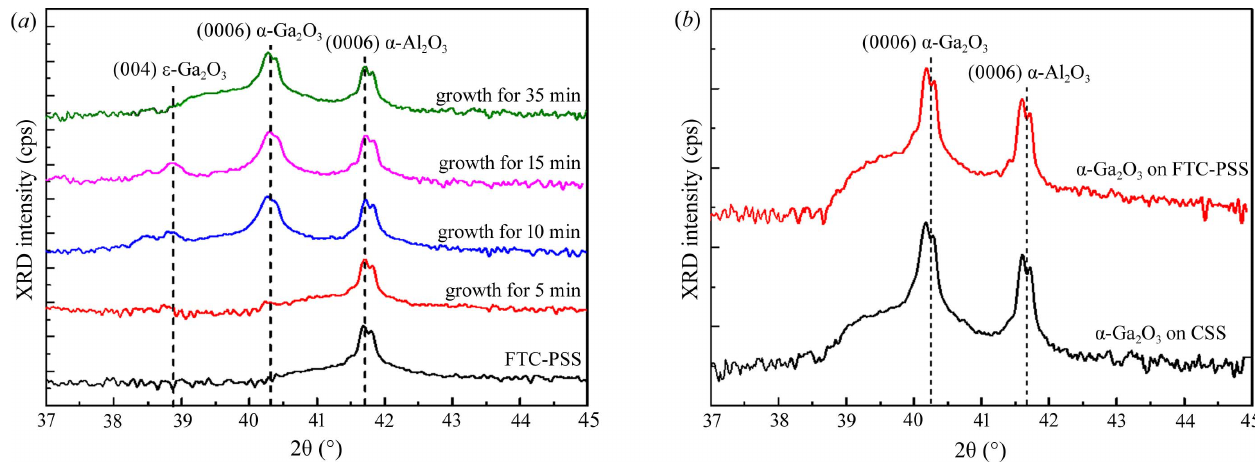
Figure 2 XRD spectra from (cid:6) –2 (cid:6) scans of the (cid:2) -Ga 2 O 3 epilayers grown on CSS and CF-PSS; ( a ) (cid:2) -Ga 2 O 3 epilayers on CF-PSS at different growth times for 5– 35 min and ( b ) after growth.